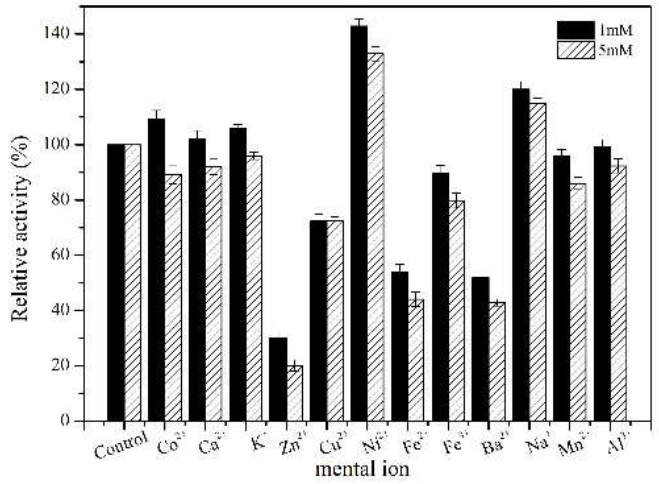
Figure 6. E ff ects of metal ions on the activity of TcPanD-R98H / K305S. Figure 6. Effects of metal ions on the activity of TcPanD-R98H/K305S.